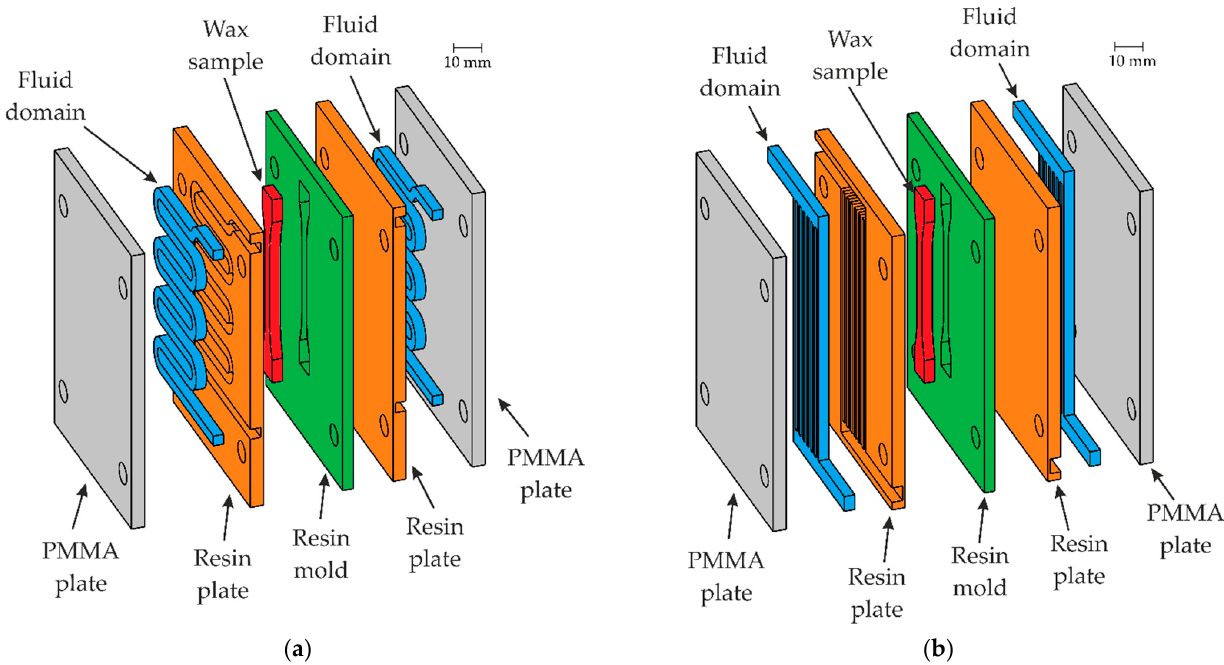
Figure 6. Exploded view of wax injection mold assembly: ( a ) with squared cooling channels (blue), ( b ) and finned cooling channels (blue).